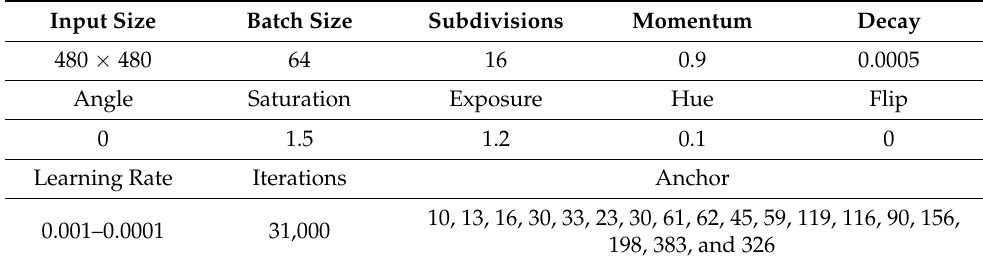
Table 7. Experimental parameters of YOLOv3.